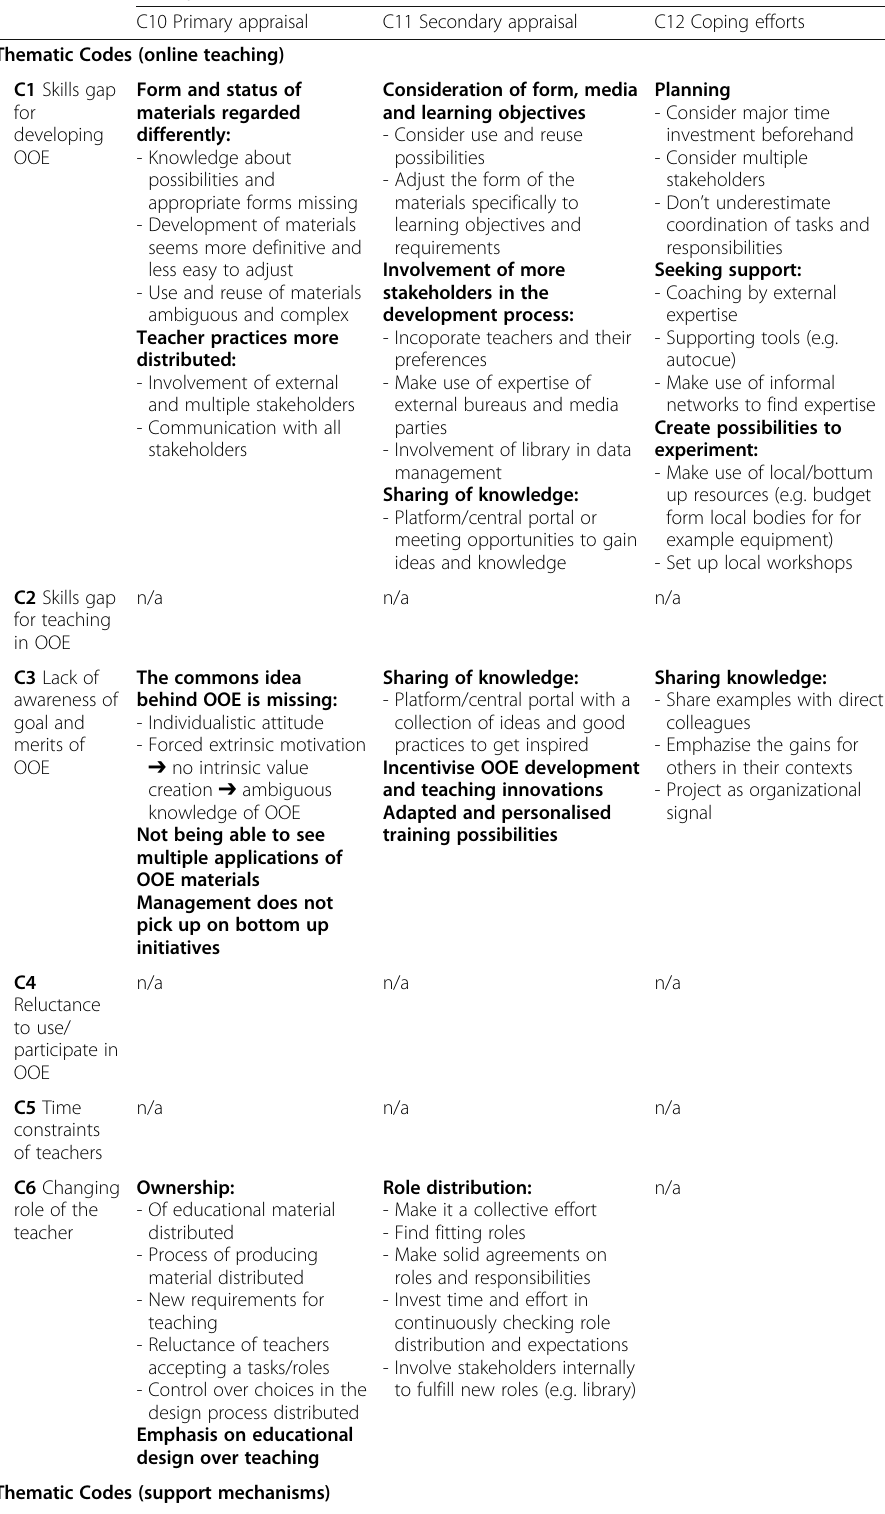
Table 6 Charting of focus group